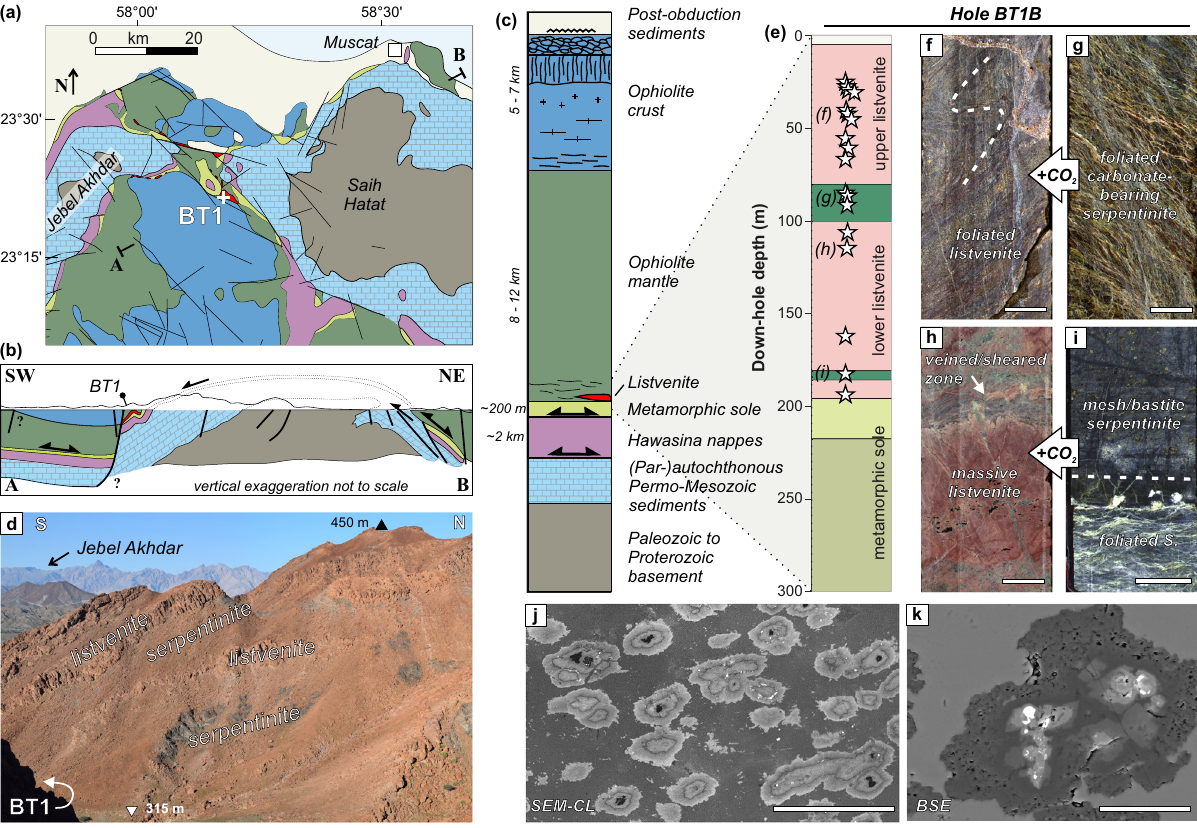
Fig. 1 Geological context and key features of Oman Drilling site BT1. a Simpli fi ed geological overview of the northern Samail massif in Northern Oman (adapted after 73 ), with site BT1 indicated, b schematic cross-section, and c simpli fi ed stratigraphy of the Samail ophiolite and underlying units (from 74 ). Present-day thickness of units in the area is commonly reduced due to tectonic thinning. d Field view of listvenites and serpentinites close to site BT1. Serpentinite is commonly covered by listvenite scree. e Overview of Hole BT1B (modi fi ed from 32 ) with the location of studied samples. Split core images of f foliated and folded listvenite (sample BT1B_21-3_35-40), g foliated carbonate-bearing serpentinite (sample BT1B_39-4_14-18), h veined shear zone